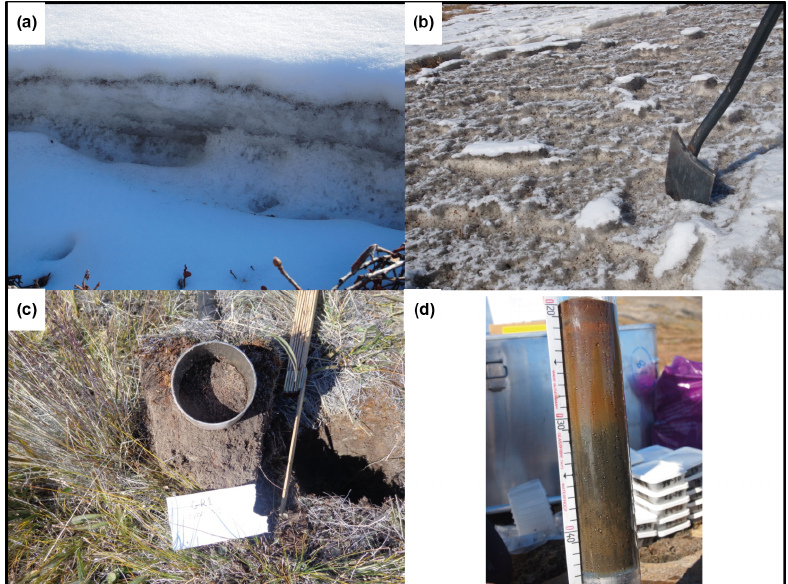
Figure 7. Photos of snow with inclusions of eolian deposits (a, b) , soil sampling in steel cylinders (c) and sediment core from the lake bottom (d)